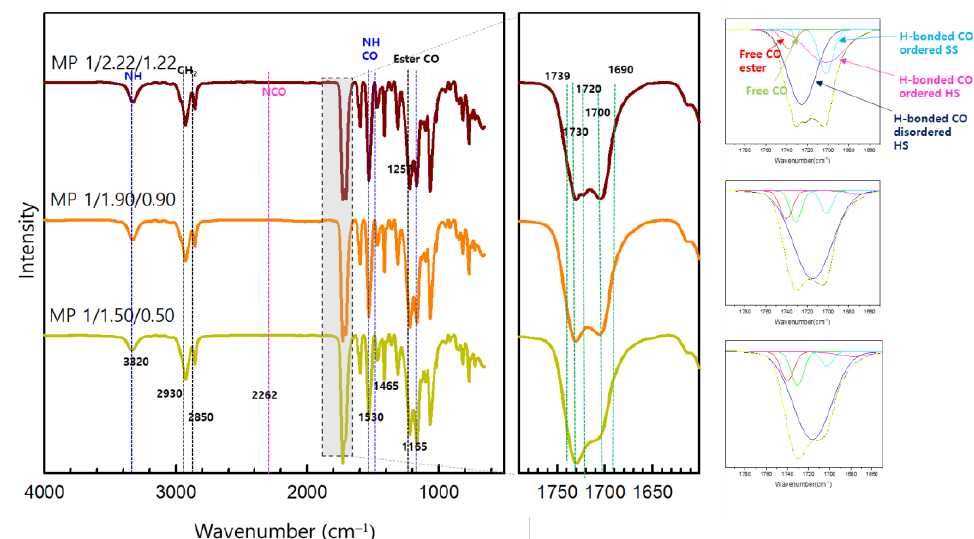
Figure 3. FTIR spectra of the bio-based shape memory thermoplastic polyurethanes, and curve fitting of the carbonyl region. Table 3. Percentages of the various C=O species present in the shape memory thermoplastic polyurethanes, as determined by deconvolution of the FTIR absorbance bands in the range of 1750–1680 cm −